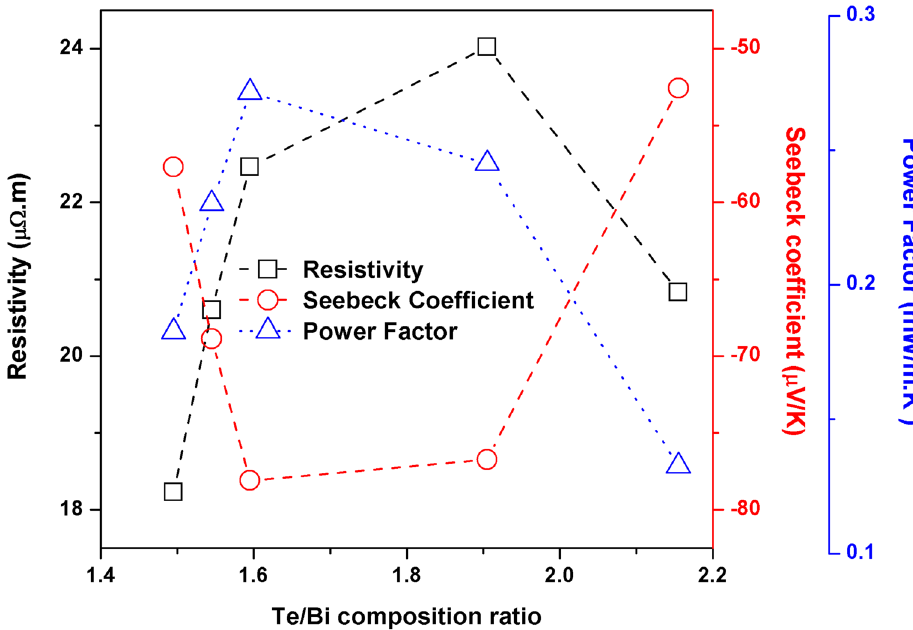
Figure 10. The electrical resistivity, Seebeck coefficient and PF of the annealed Bi–Te thin